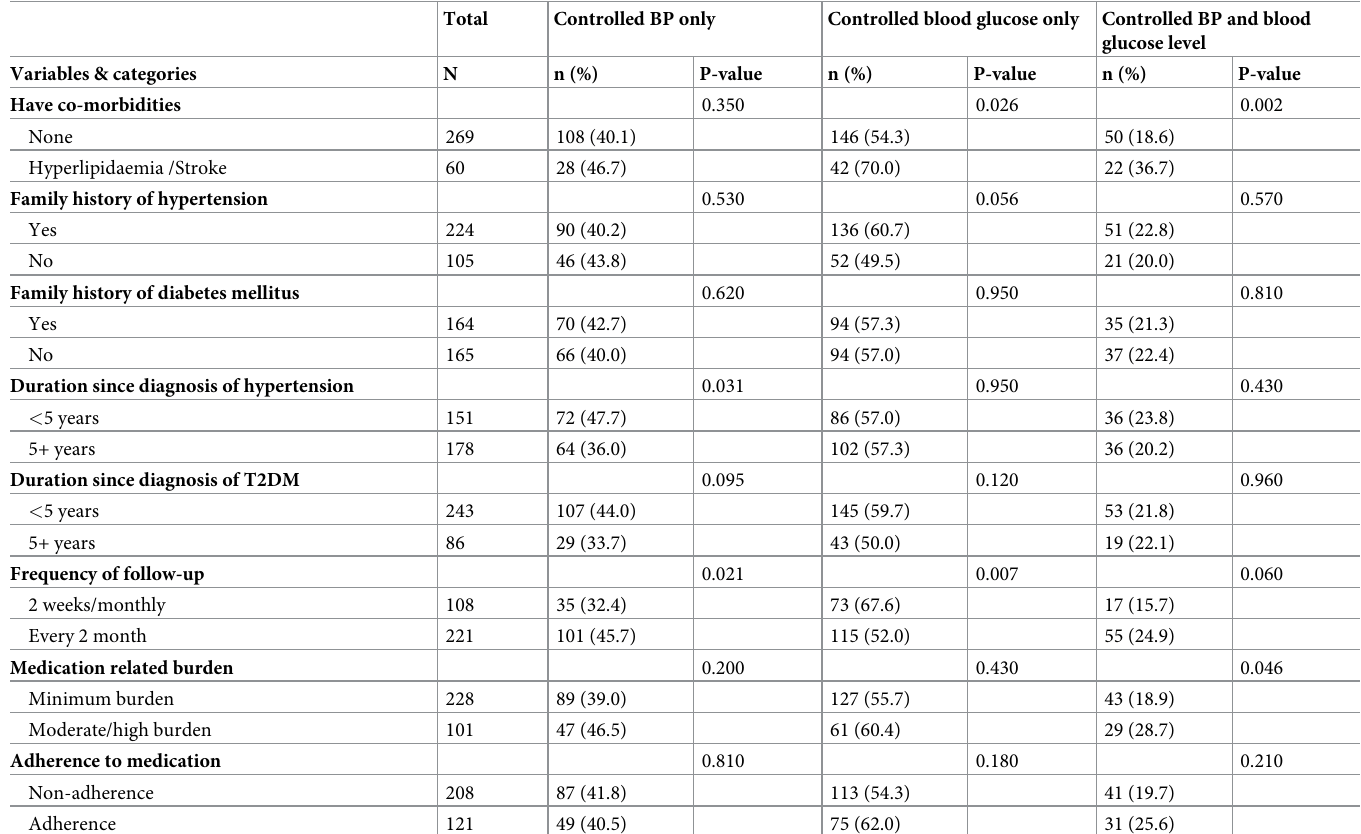
Blood glucose control levels only. The bivariate analysis showed that sex (p = 0.001), age group (p = 0.023), highest education (p = 0.006), employment status (p = 0.049) and monthly income (p = 0.011) were the statistically significant socio-demographic factors associated with the blood glucose levels of participants. The statistically significant clinical and medication related fac- tors associated with blood glucose level included number of anti-hypertensive medications (p = 0.015), frequency of daily dose of medication (p = 0.002), presence of hyperlipidaemia or stroke co-morbidity (p = 0.026) and frequency of follow-up visits to clinic (p = 0.007) (Table 3). Blood pressure and blood glucose control levels. The bivariate analysis showed that high- est level of education (p < 0.001) and employment status (p = 0.004) were the only socio-demo- graphic characteristics associated with controlled BP and blood glucose levels. Number of anti- hypertensive medications (p < 0.001), number of anti-diabetic medication (p < 0.001), dyslipi- daemia medication (p = 0.023), soluble aspirin (p = 0.036), presence of hyperlipidaemia/stroke comorbidities (p = 0.002), and medication related burden (p = 0.046) were the clinical- and medication- related factors associated with controlled BP and blood glucose level (Table 3). Multivariable binary logistic regression model of factors associated with outcomes of the study Blood pressure control levels. In the multivariable binary logistic regression model, the adjusted odds of controlled BP compared to those less than 50 years old was over 5 times